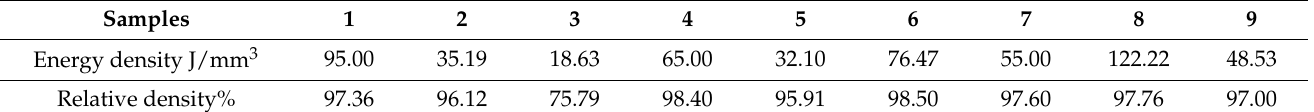
Table 4. Density measured using Archimedes method.